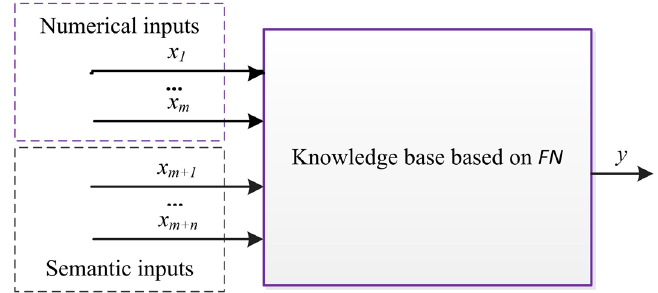
Figure 8. SFS structure after knowledge base combination based on FN